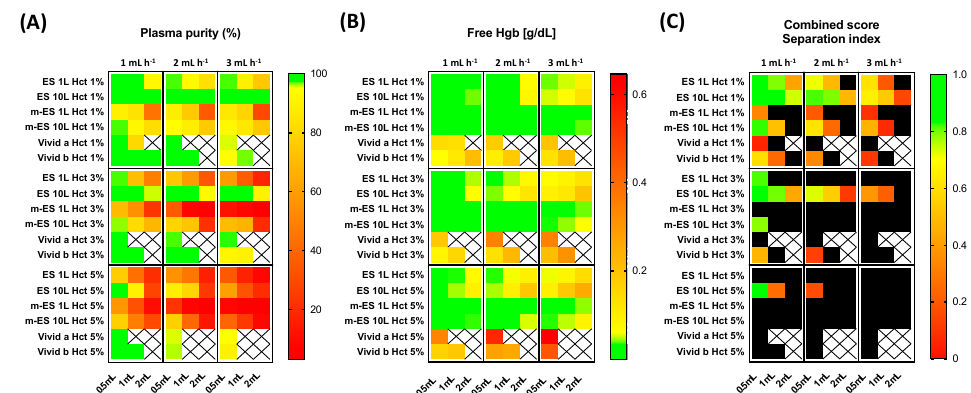
Figure 4. Electrospun Membrane Low Hematocrit Separation Performance. ( A ) Plasma purity is represented by a triple color gradient from green (100%, corresponding to no cell detected) to red (0%) as a function of Hct in for three different treated blood volumes (0.5 mL, 1 mL, and 2 mL) and blood flow rates (1 mL h − 1 , 2 mL h − 1 , and 3 mL h − 1 ), organized in quadrants for clarity. The baseline value is set at 95% and represented in yellow to enable rapid reading and selection (green corresponding to plasma purity > 95%). Crosses indicate sets of parameters where data were not acquired because the devices could not handle high pressures. ( B ) Free hemoglobin concentration (g dL − 1 ) as a function of Hct in for three different treated blood volume (0.5 mL, 1 mL, and 2 mL) and blood flow rate (1 mL h − 1 , 2 mL h − 1 , and 3 mL h − 1 ) and represented as a triple gradient from green (0 g dL − 1 ) to red (6 g dL − 1 ). The baseline value is set as 0.06 g dL − 1 (yellow). ( C ) The combined score or separation index is calculated from the plasma purity (%) and free Hgb values. A score of 1 indicates the maximum score for 100% plasma purity and 0 g dL − 1 free Hgb. The score index calculation was evaluated according to Equation (8). Here, the double threshold is set at 0.15 g dL − 1 (Maximum value) and 85% plasma purity (Minimum value), at which point the score appears in the heat map as a black square. The baseline value is set at 0.5 arbitrary units. The threshold can be changed to enable the user to exclude underperforming membranes from the selection (see Figure S2 for other threshold